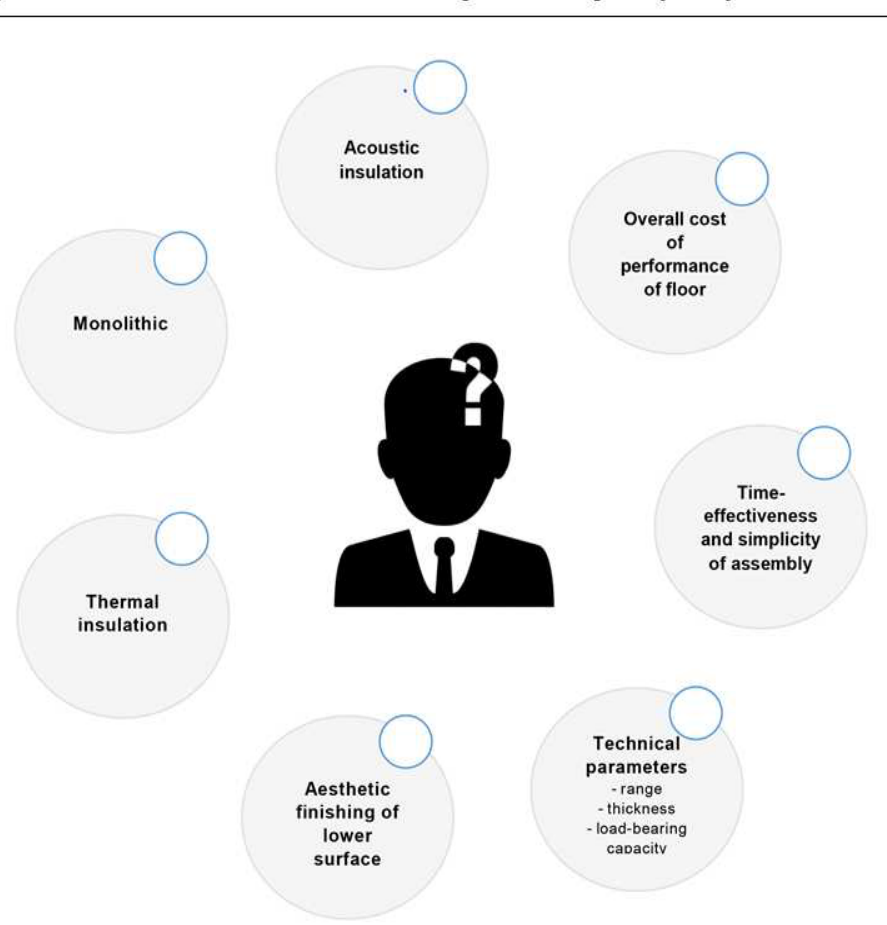
Fig. 7. Customer needs map on the example of floor